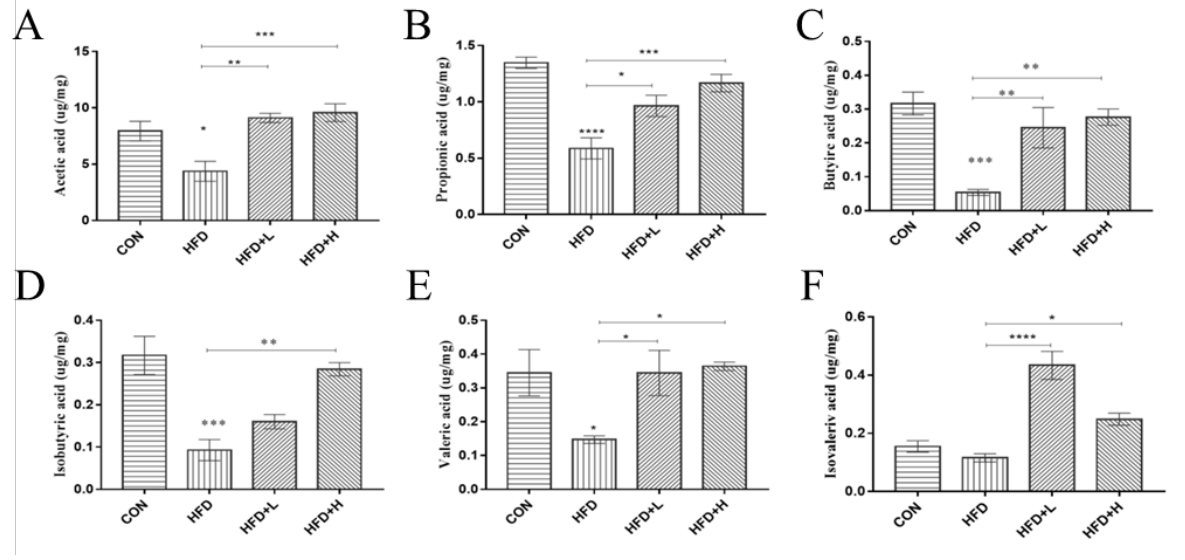
Figure 10. Colon content of SCFAs in each group after CIP intervention. ( A ) acetate, ( B ) propionate, ( C ) butyrie, ( D ) isobutyrie, ( E ) valerate and ( F ) isovalerate in the colon contents. Data ( n = 5) were shown as mean ± SEM. * p < 0.05, ** p < 0.05, *** p < 0.001, and **** p < 0.0001 compared with the other